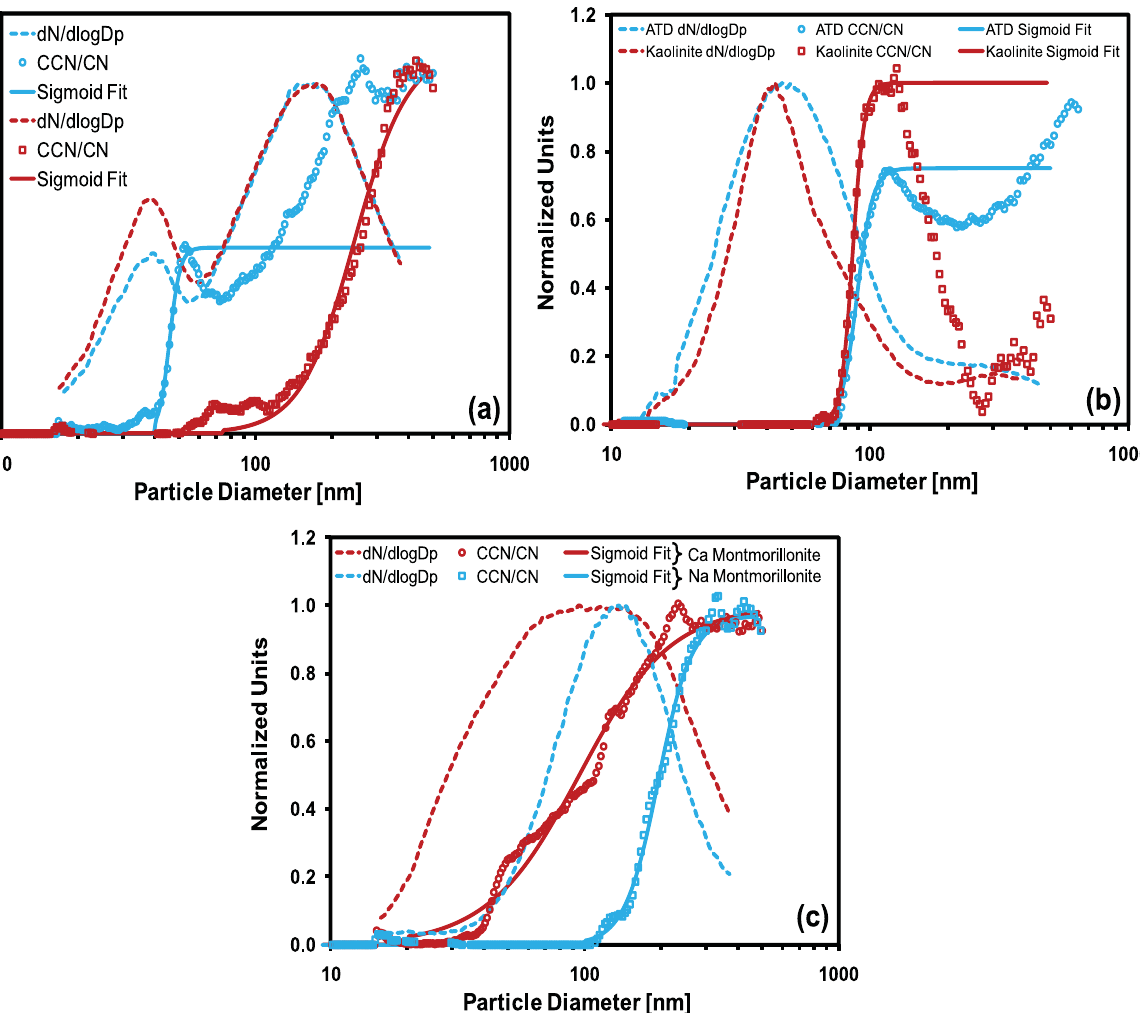
Fig. 3. CCN activation curves for wet generated (a) Illite at supersaturation equal to 0.5% (open blue square) and supersaturation equal to 0.3% (open brown square), (b) ATD (open blue square) and Kaolinite (open brown circle) at supersaturation equal to 0.2%, and (c) Na- Montmorillonite and Ca-Montmorillonite at supersaturation equal to 0.3% (open blue square) and supersaturation equal to 0.55% (open brown circle). Also shown in dashed lines are normalized particle number size distributions for wet generated sample. The sigmoid curve (thick line) is fit to CCN activation data